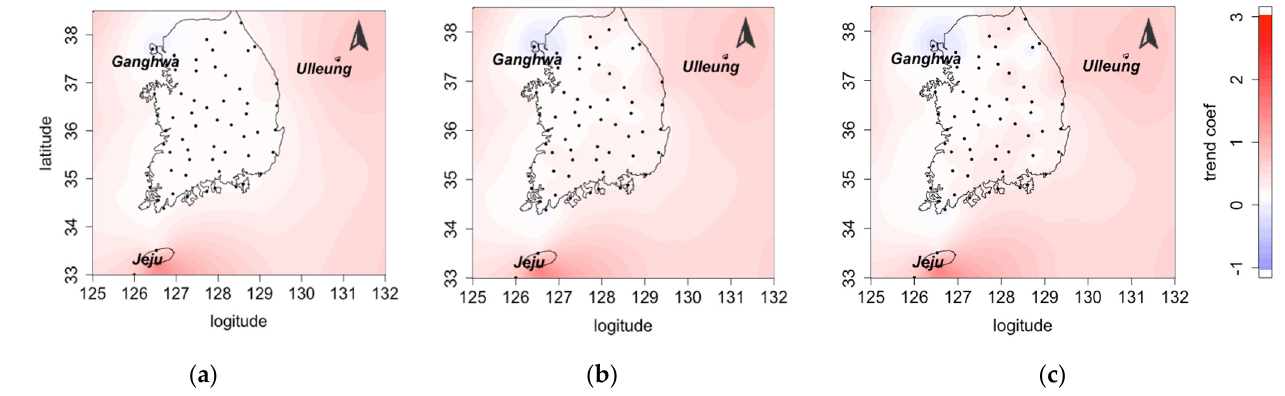
Figure 8. Trend map of southern portion of the Korean Peninsula with 7 clusters ( a ), 12 clusters (minimum BIC) ( b ) and 19 clusters ( c ).